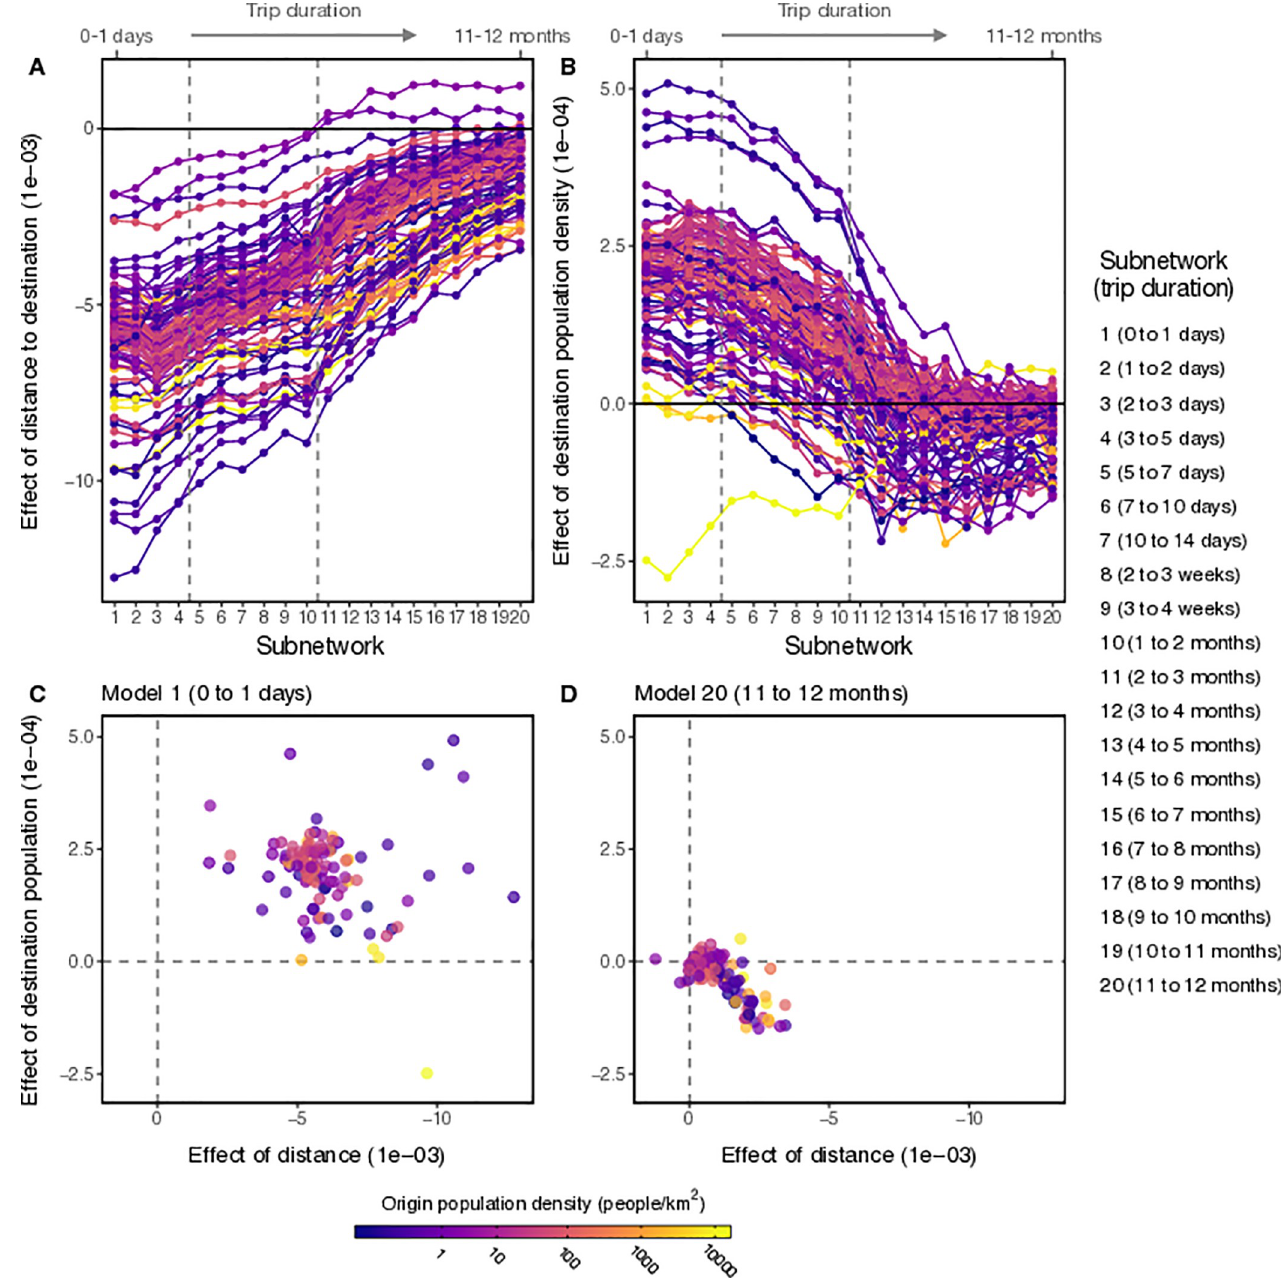
Fig 4. The drivers of trip volume across varying trip durations. The effect of distance to destination A) and destination population size B) on trip volume plotted across the 20 duration-restricted subnetworks. Each colored line represents one of the 105 districts with the population density of the origin district is indicated by the color bar. Dashed vertical lines indicate the network topology thresholds identified by the changepoint analysis. Scatterplots showing the joint distribution of effect sizes for distance (x-axis) and destination population (y-axis) for C) the model with the shortest duration (Model 1, 0–1 days) and D) the model with the longest duration (Model 20, 11–12 months). Comparison of C and D show that the effect size of both covariates is reduced to near-zero effect for longer trip durations.